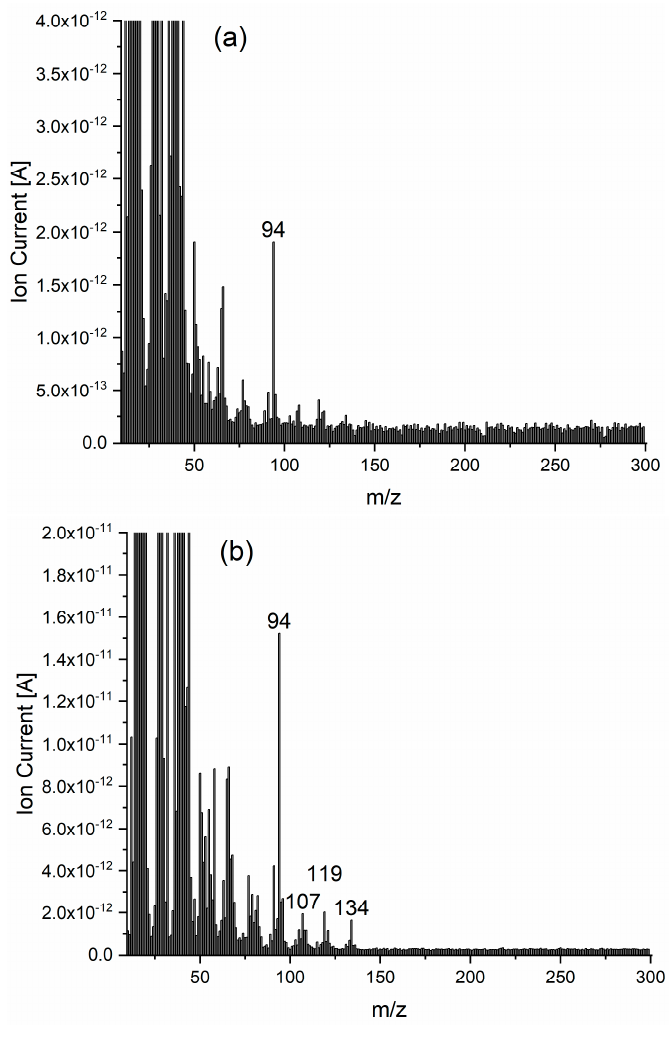
Figure 6. ( a ) MS spectrum of the gases evolved during TG measurement of the polymer formed amine 5 and DGEBA at 379 ◦ C and ( b ) MS spectrum of the gases evolved during TG measurement of from amine 5 and DGEBA at 379 °C and ( b ) MS spectrum of the gases evolved during TG measure- the polymer formed from IPDA and DGEBA at 369 ◦ ment of the polymer formed from IPDA and DGEBA at 369 °C.